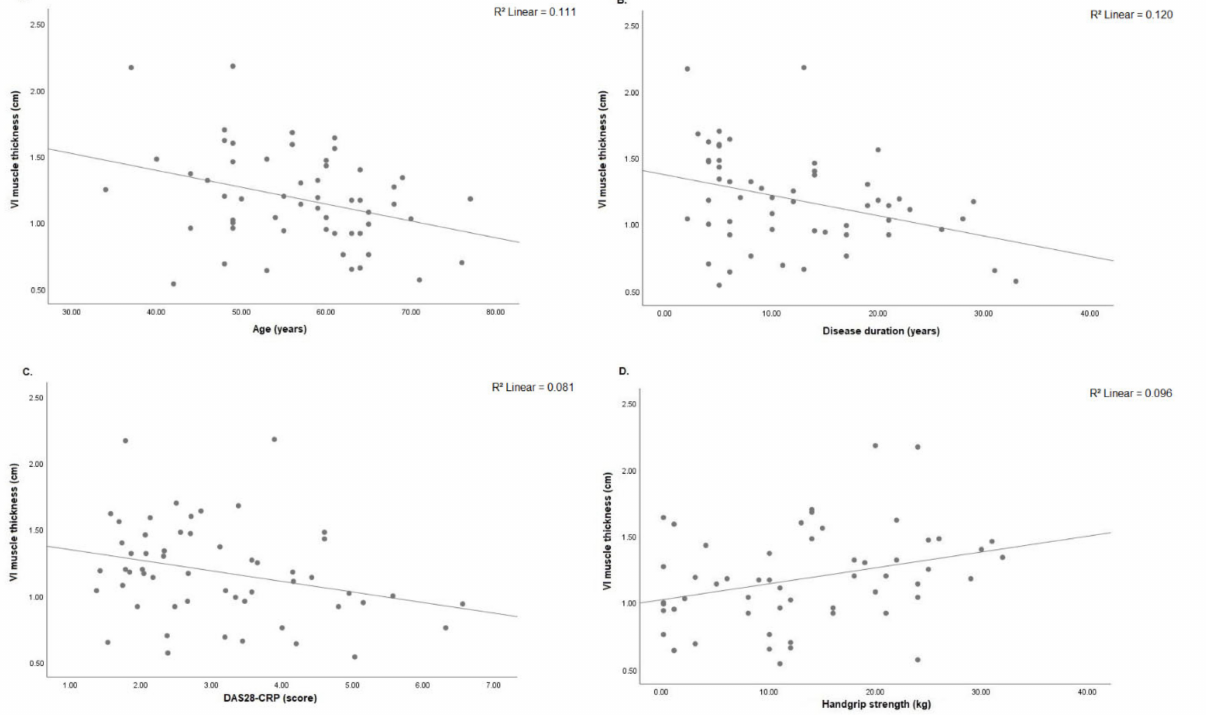
Figure 5. ( A ) Correlation analysis was significant between VI muscle thickness and age ( n = 55, r = − 0.333; p = 0.013), ( B ) disease duration ( n = 55, r = − 0.372; p = 0.005), ( C ) DAS28-CRP ( n = 55, r = − 0.285; p = 0.035) and ( D ) handgrip strength ( n = 55, r = 0.309; p = 0.022). VI: vastus intermedius; DAS28-CRP: 28-joint disease activity score, C-reactive protein; kg: